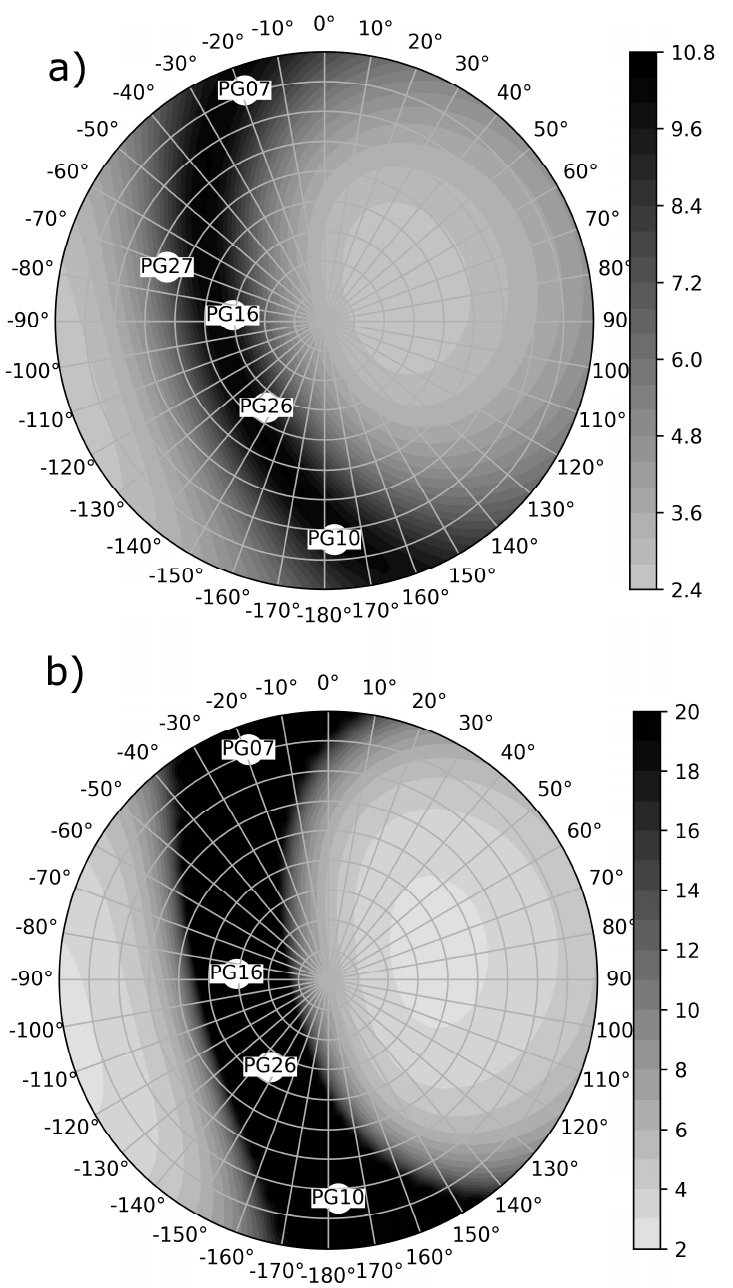
Figure 4. Heatmaps of PDOP calculated for a four-degree grid of transceiver locations at the observation point. Bottom panel ( b ): PDOP values with all visible satellites; top panel ( a ): PDOP values with Satellite 27 removed. Gray tones depict the PDOP value. In the top panel, the heatmap is limited to 20 for readability.